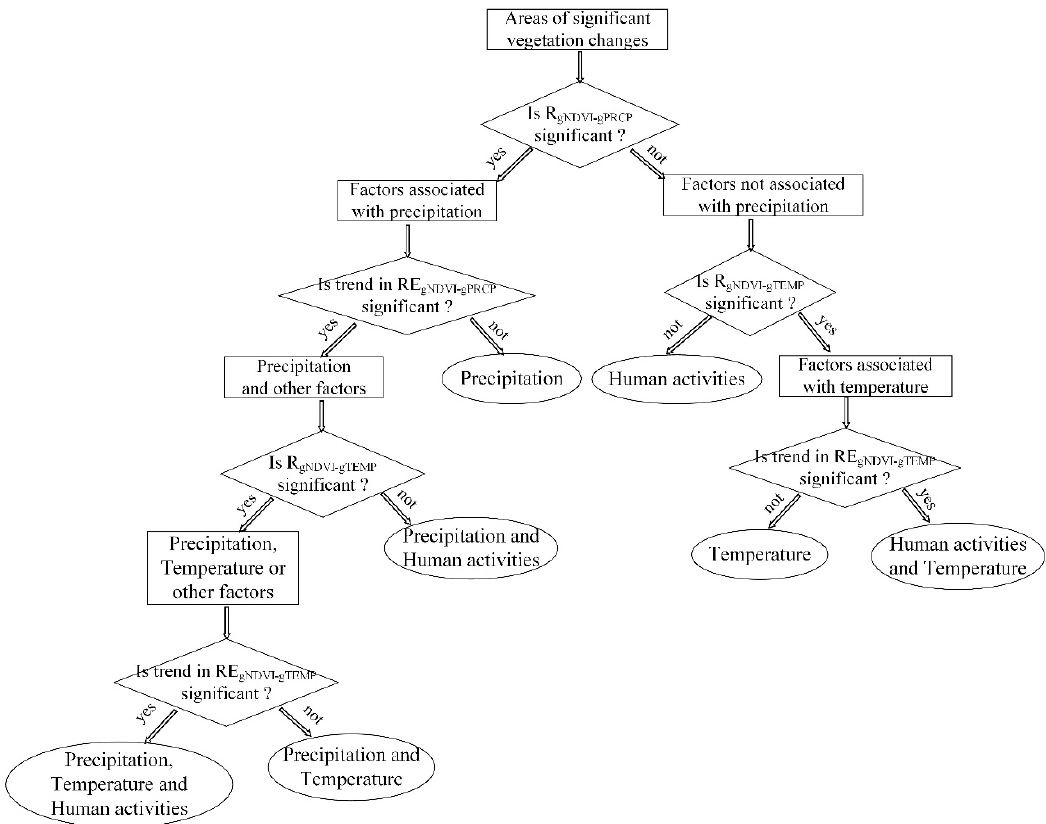
Figure 3. The flowchart of the new classification framework.